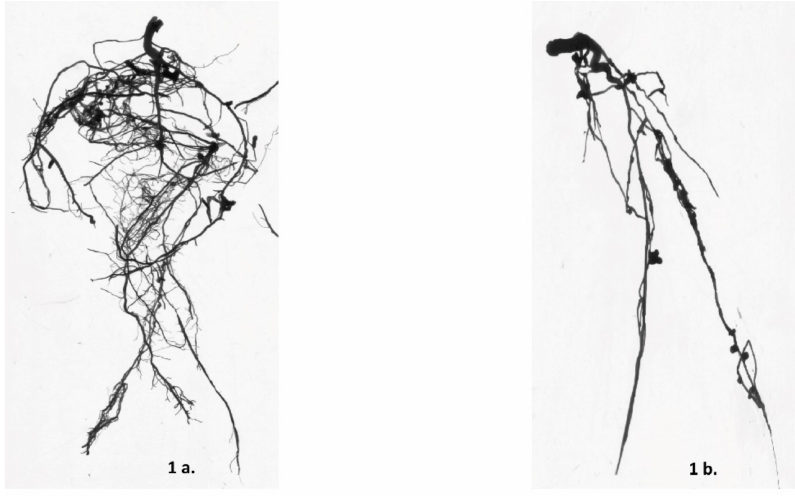
Figure 1. Root scan of “Moitree” ( a ) and “Farmer-2” ( b ) under rice-fallow ecology in WINRHIZO software package.